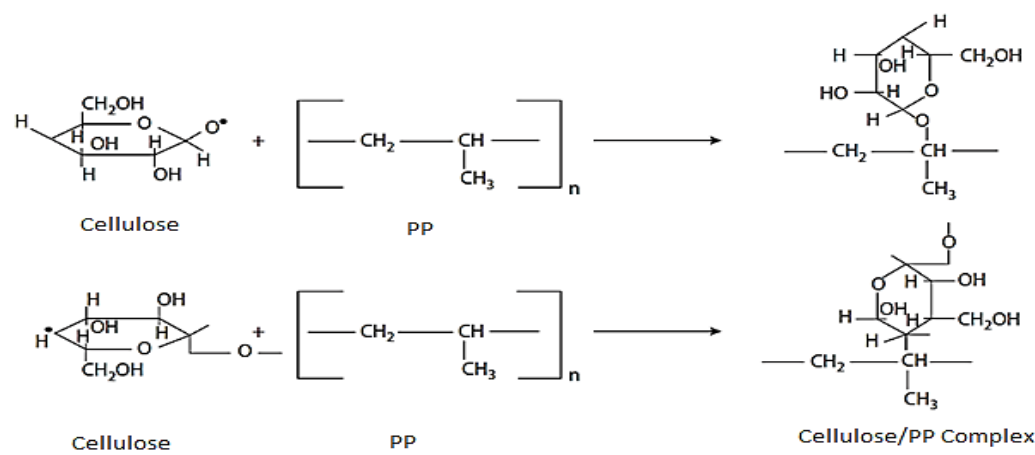
Figure 9: (b) A possible cross-linking mechanism between cellulose and PP